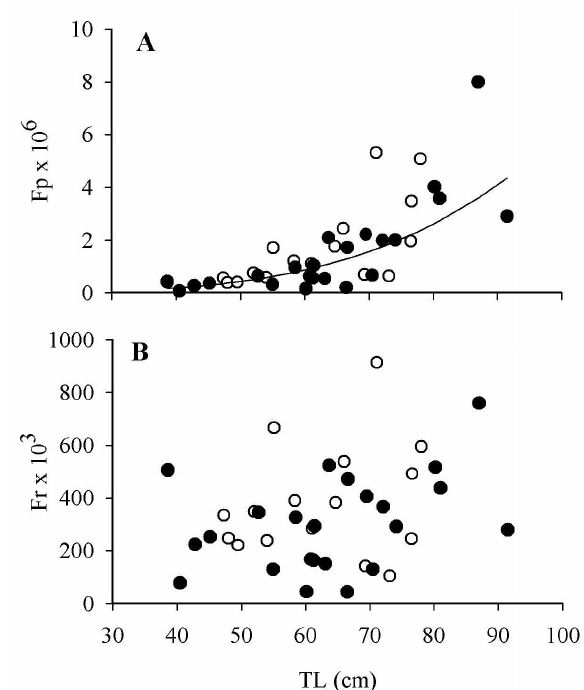
Fig . 9. – Relationship of potential (A) and relative (B) fecundity with TL (cm) of Epinephelus marginatus specimens from artisanal ( l ) and spear recreational (  ) fisheries. The values of the relation- ship are given in Table